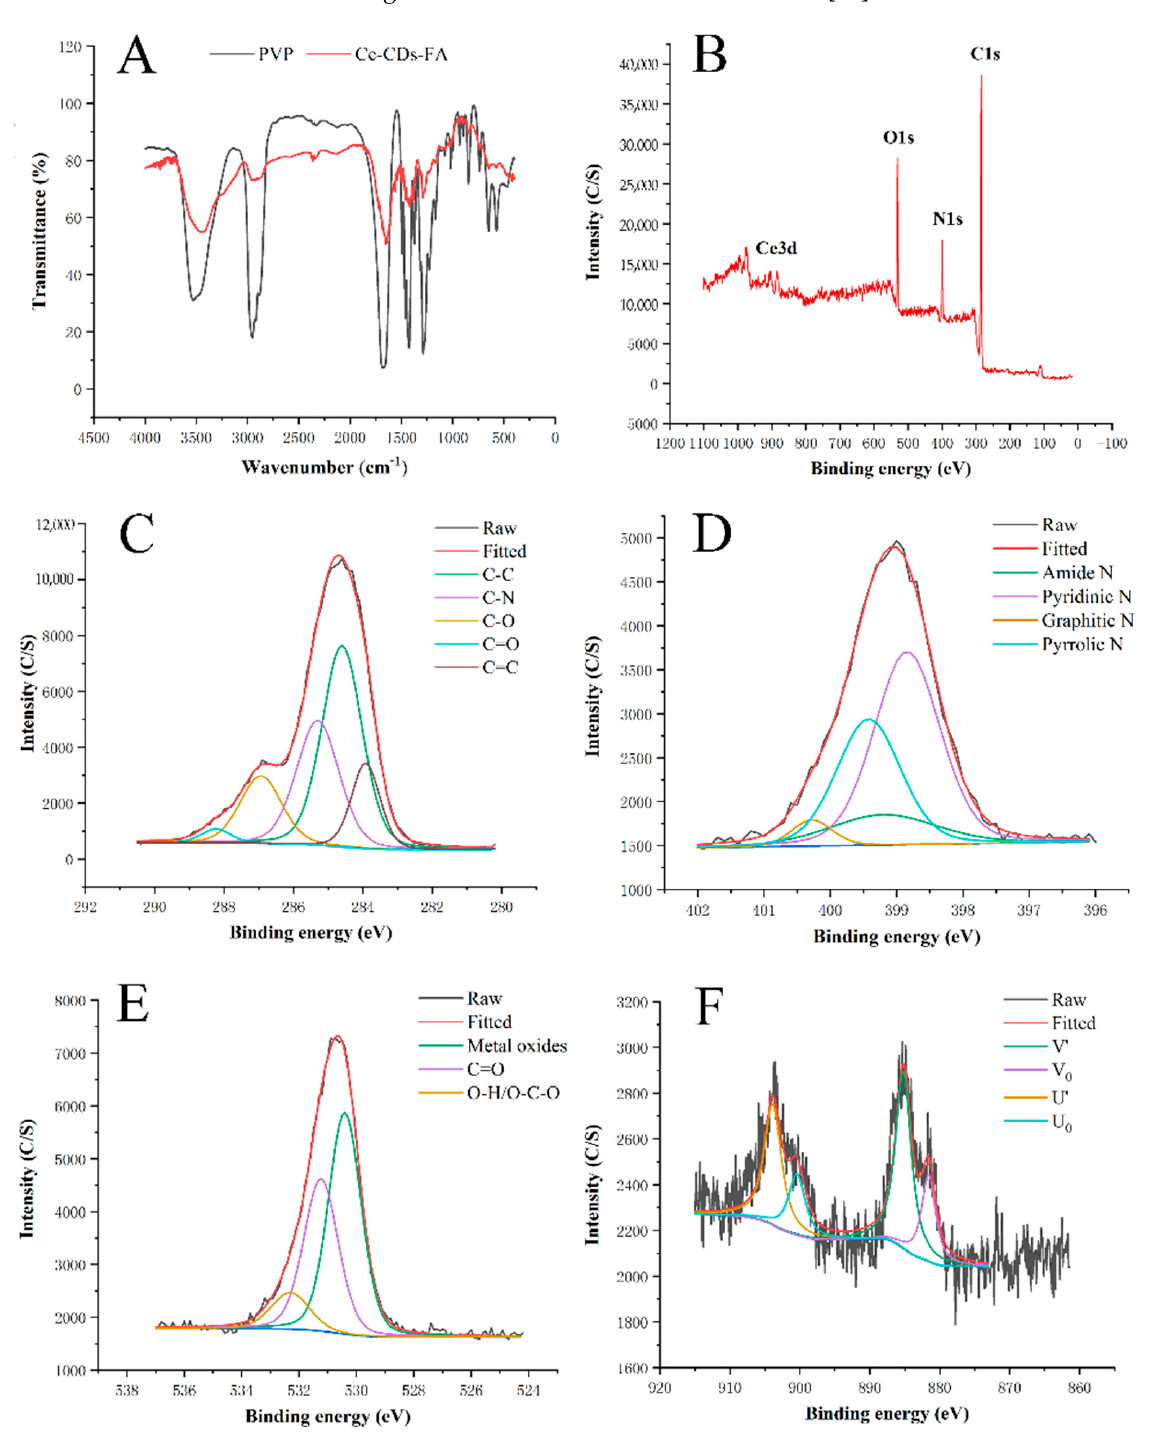
Figure 2. ( A ) FT-IR spectra of PVP and Ce-CDs-FA. ( B ) XPS spectrum of Ce-CDs-FA. ( C ) C 1s zone. ( D ) N 1s zone. ( E ) O 1s zone. ( F ) Ce 3d zone.